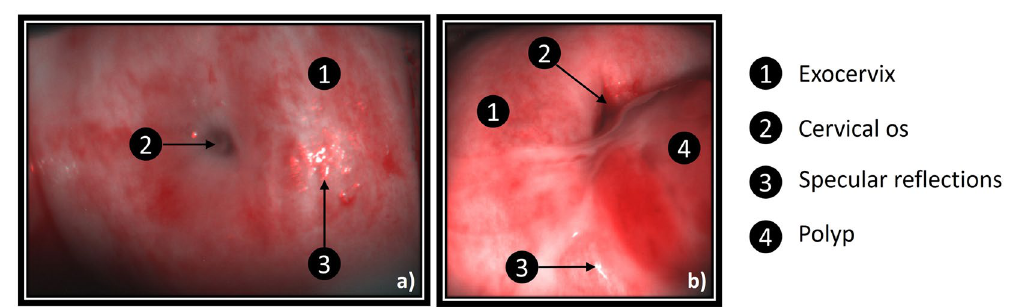
Figure 5. In vivo unpolarized RGB pictures of two uterine cervices. ( a ) Healthy uterine cervix (Cervix 1). ( b ) Healthy uterine cervix with polyp (Cervix